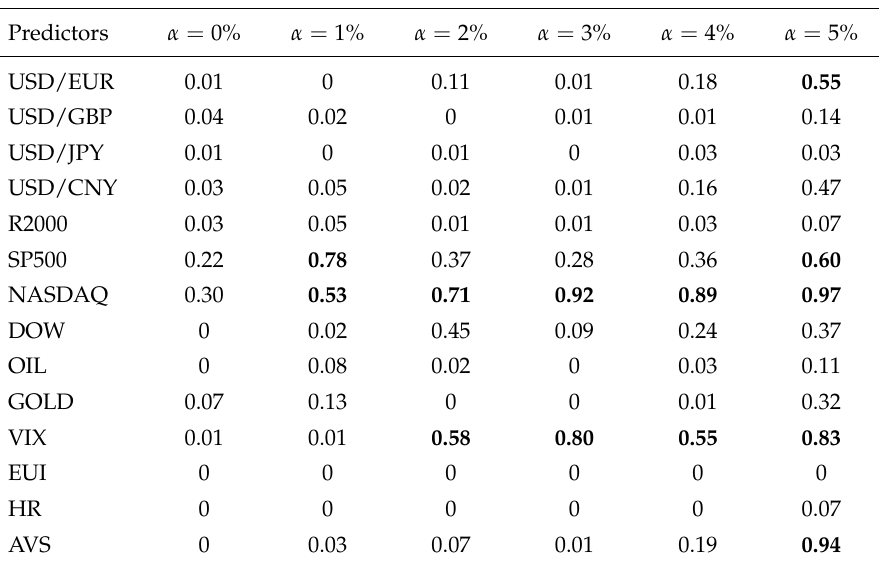
Table 5. Posterior probabilities of inclusion of the explanatory variables for the binary ETH series for the period ranging from 1/2016 to 11/2019 The probabilities of the variables that are included in the median probability model, i.e., the variables with probability of inclusion above 0.5, are highlighted with